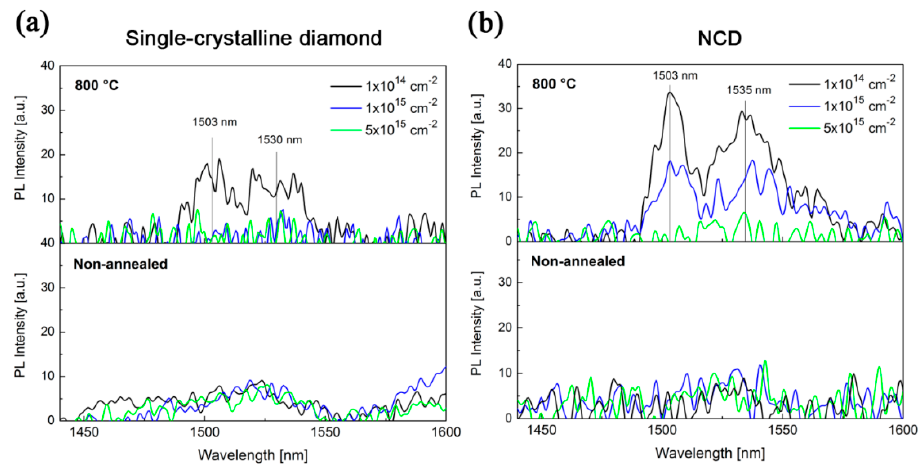
Figure 6. The luminescence spectra of the single-crystalline diamond and NCD samples implanted with various fluences and annealed at 800 °C in vacuum.